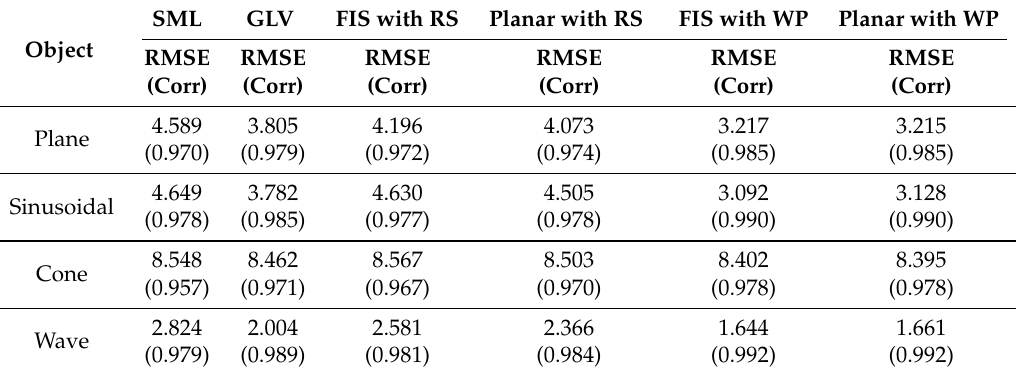
Table 1. Performance Comparison for Various SFF methods using Various Synthetic Objects.